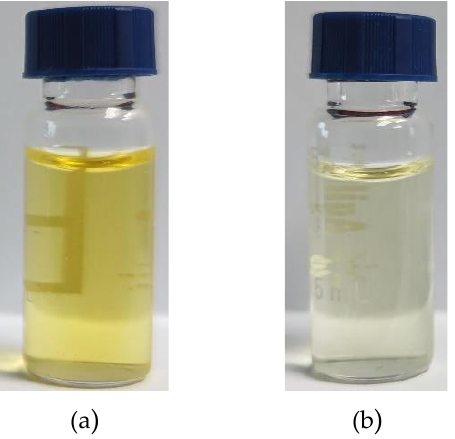
Figure 7. Comparison of maize extract before and after purification: (a) Before purification; (b) After purification.